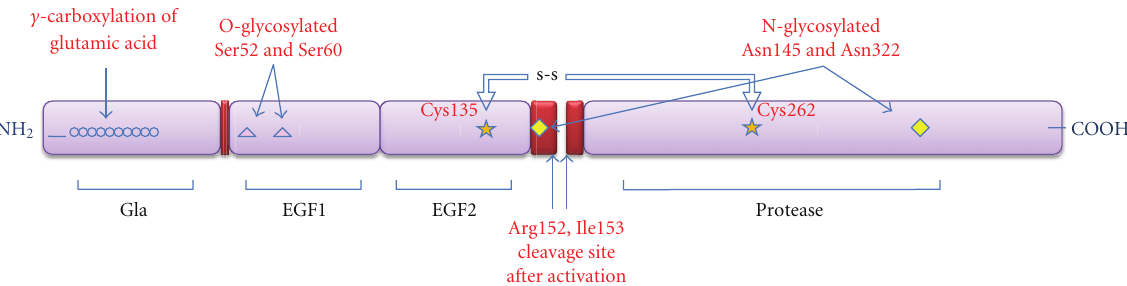
Figure 1: Human coagulation factor VII. FVII is a serine protease of 406 residues. Di ff erent domains of FVII are shown. Posttranslational modifications of the FVII molecule include (1) γ -carboxylation of 10 glutamic acid residues in the N-terminal part of the molecule, (2) N-glycosylation of asparagine residues in positions 145 and 322, and (3) O-glycosylation of serine residues 52 and 60. , gamma- carboxyglutamic acid; , O-glycosylation sites; , N-glycosylation sites; Arg152 and Ile153, cleavage site generated after activation; , joining of two chains of FVIIa by a single disulfide bond between cys135 and cys262.